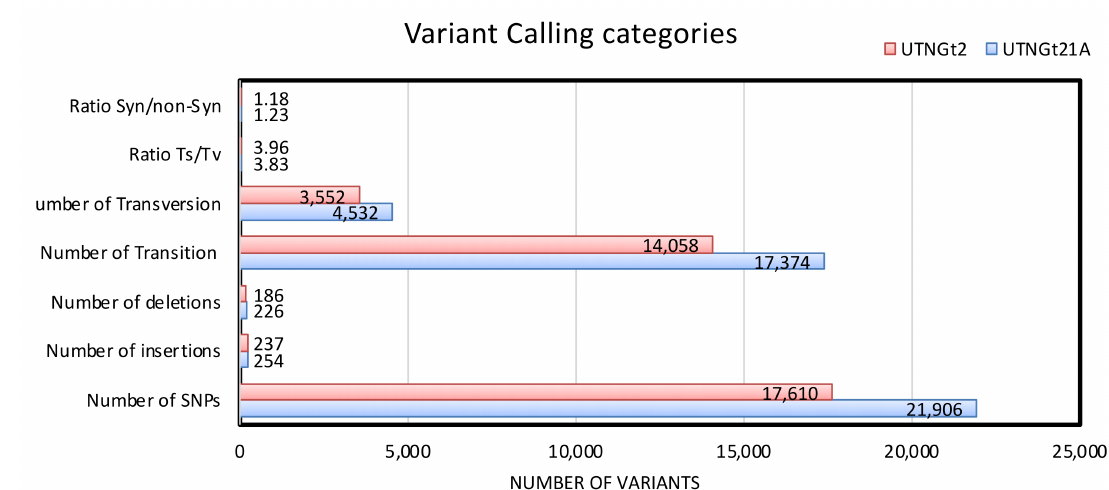
Figure 4. Cumulative summary of variant calling categories detected in the UTNGt21A and